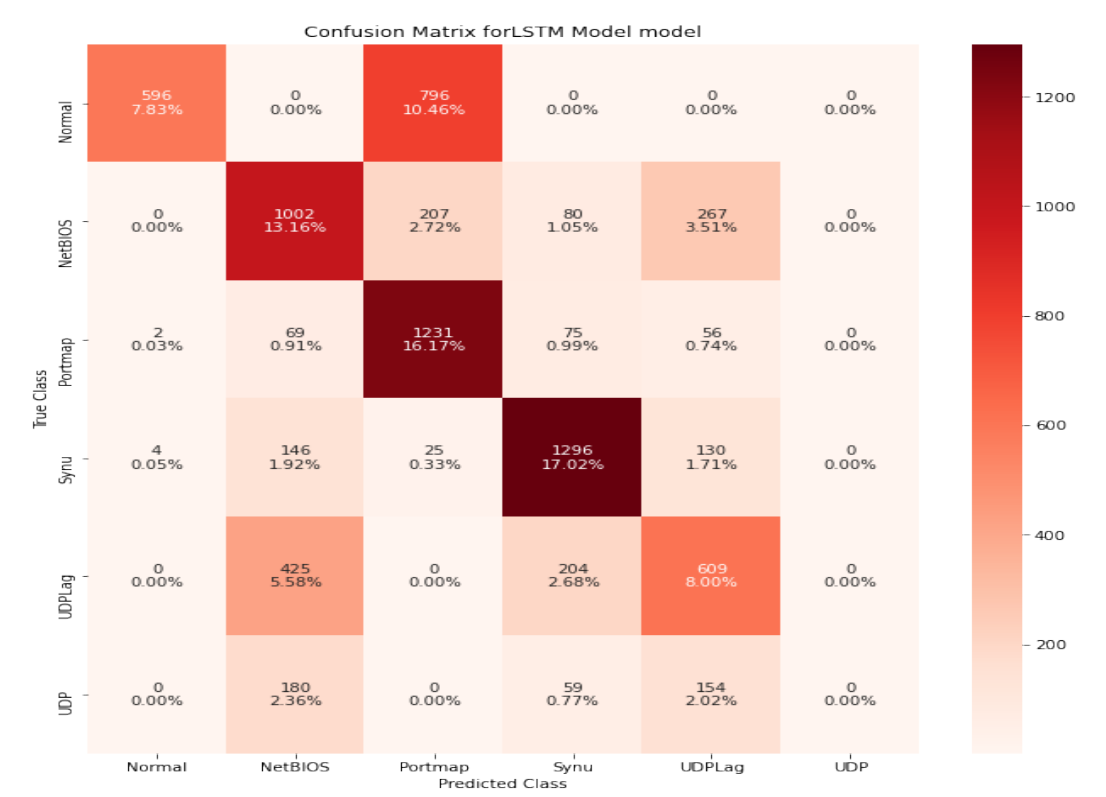
Figure 8. In the LSTM model, confusion metric.